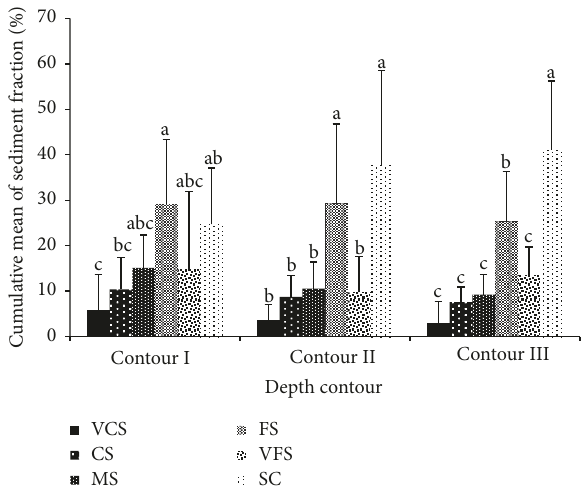
Figure 5: The average means of sediment distribution at contours I, II, and III. VCS: very coarse sand (1000 𝜇 m); CS: coarse sand (500 𝜇 m); MS: medium sand (250 𝜇 m); FS: fine sand (125 𝜇 m); VFS: very fine sand (63 𝜇 m); SC: silt-clay ( < 63 𝜇 m). Means that do not share a letter are significantly different.